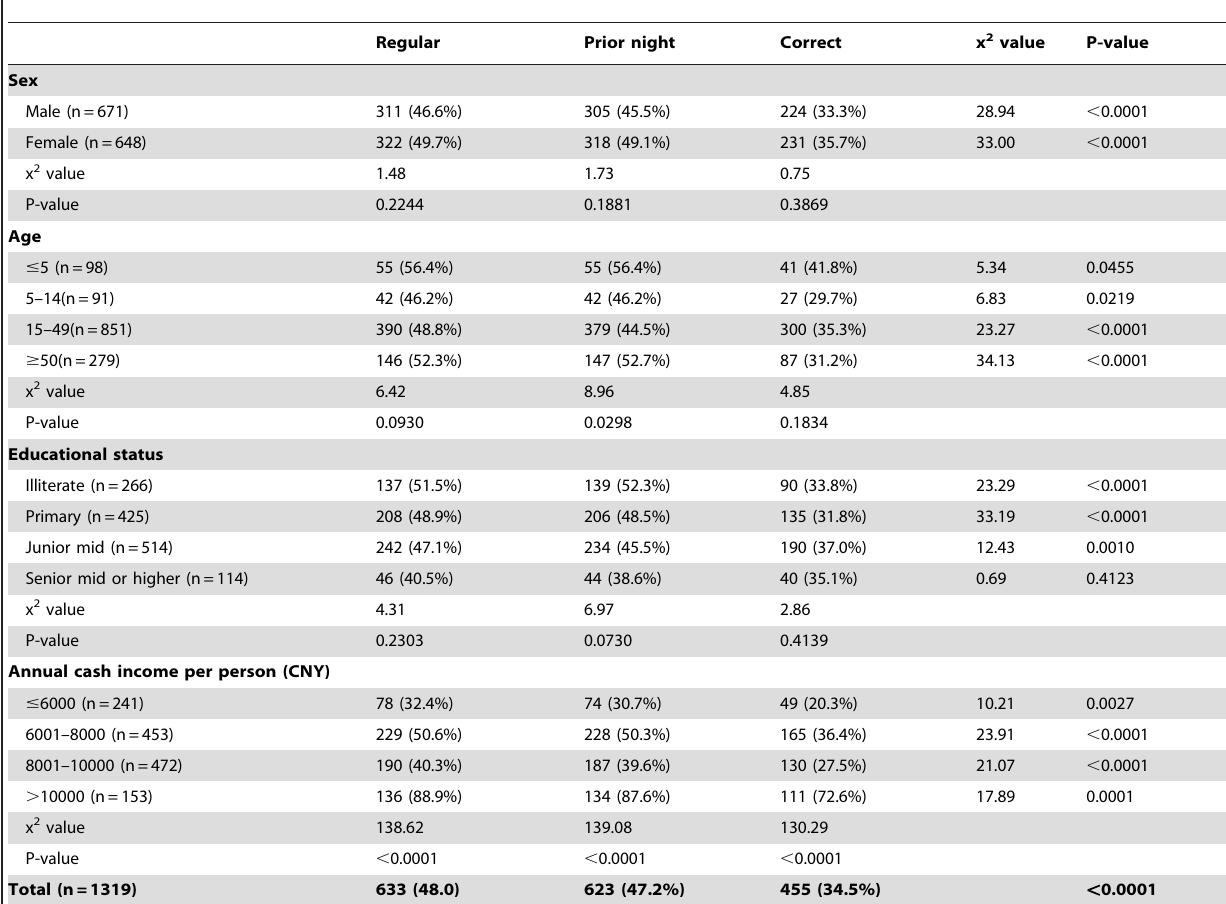
Table 1. Bed net use among different groups of Jinuo People, Yunnan,